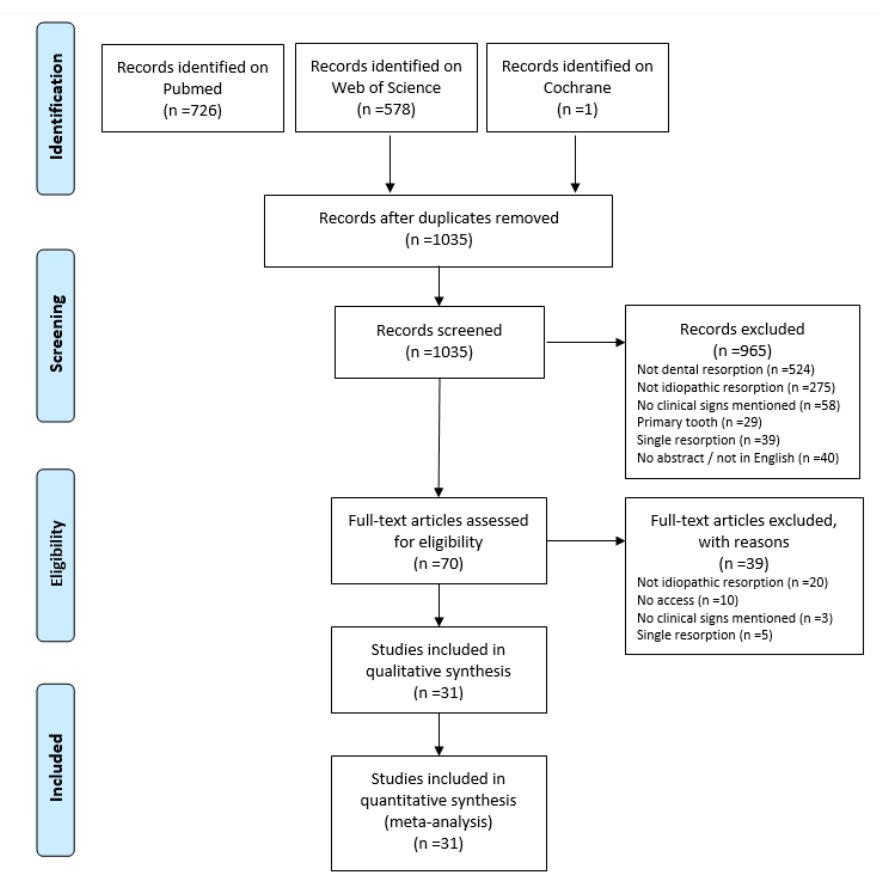
Figure 1. Flow diagram of the screening and selection process adapted from the Preferred Reporting Items for Systematic Reviews and Meta-Analyses (PRISMA) statement [11].